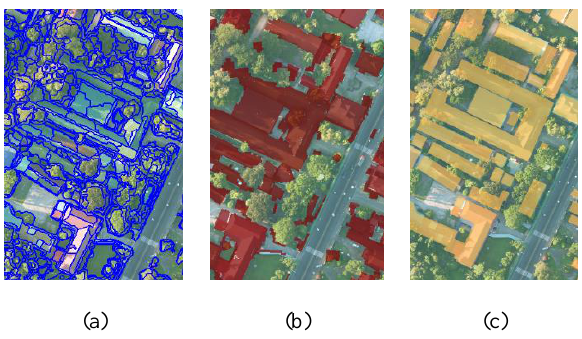
Figure 3. (a) Segmented buildings, the (b) regularized buildings and the (c) digitized buildings.